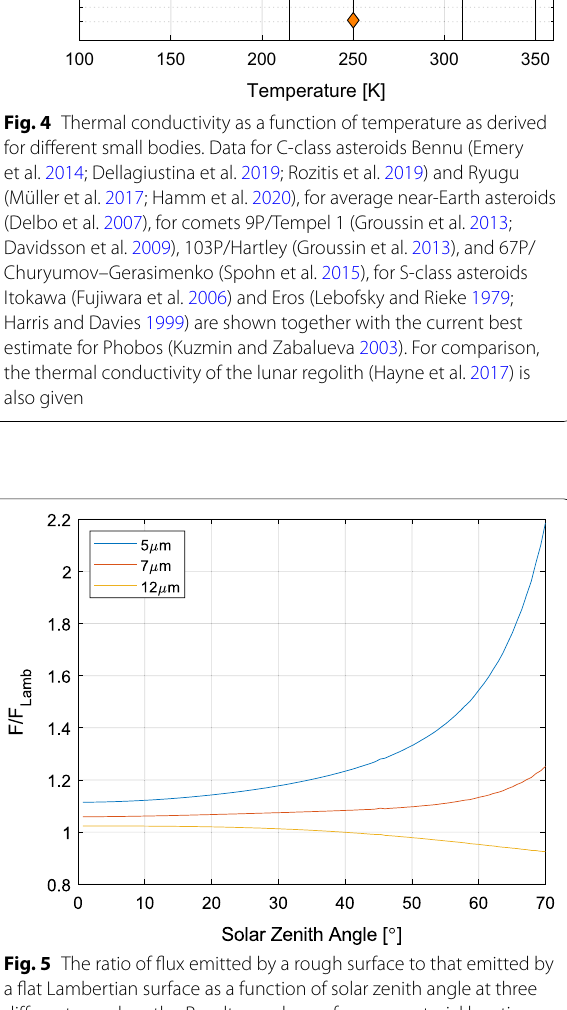
Fig. 5 The ratio of flux emitted by a rough surface to that emitted by a flat Lambertian surface as a function of solar zenith angle at three different wavelengths. Results are shown for an equatorial location and a south facing instrument, which observes the surface under an emission angle of 45